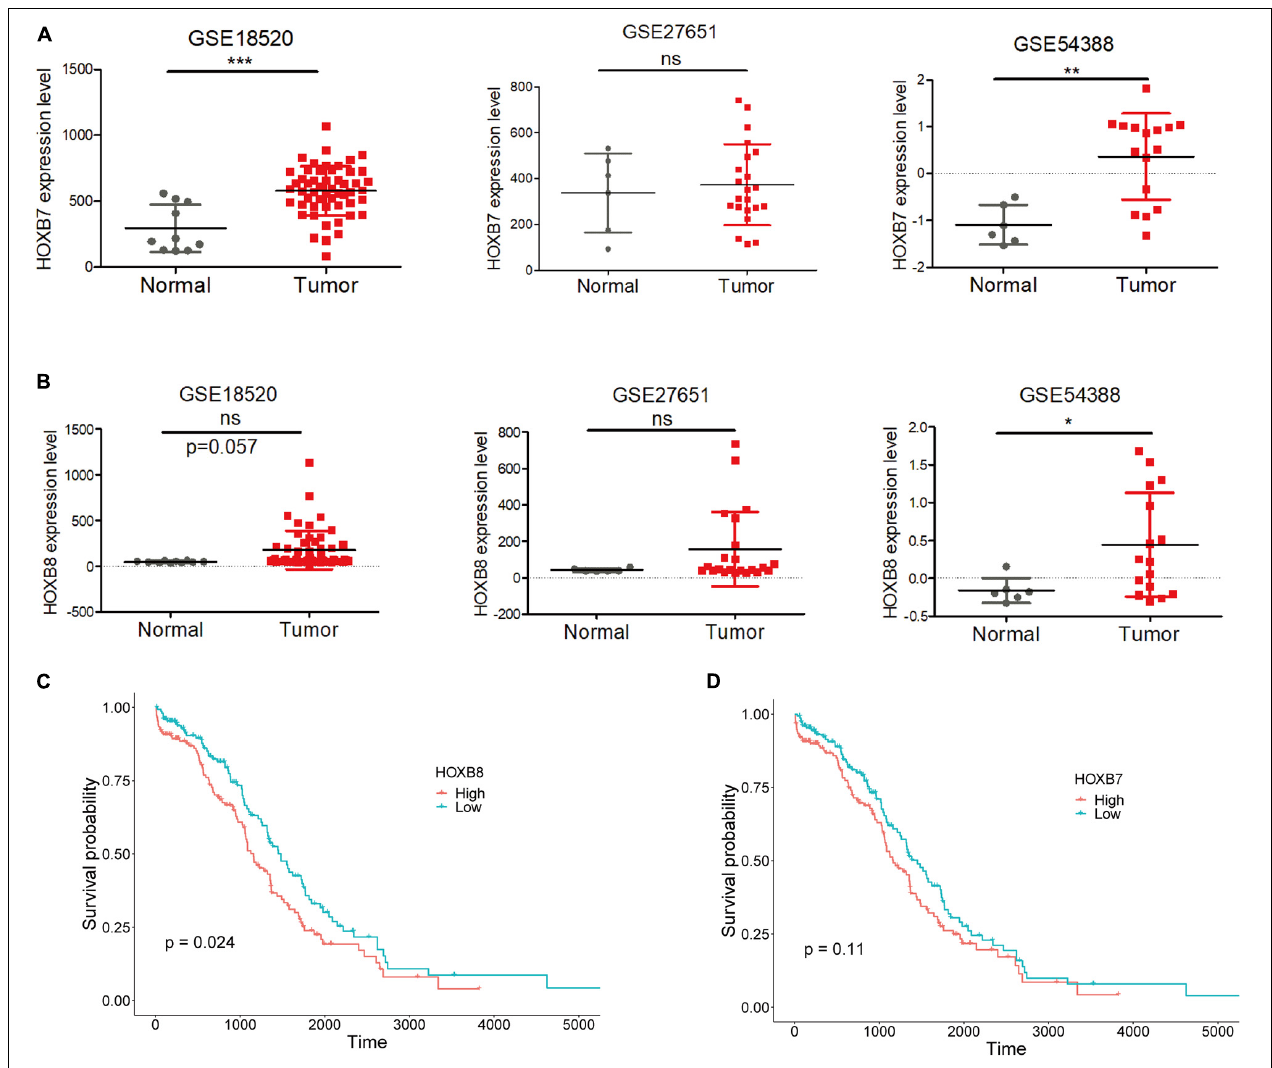
FIGURE 3 | Expression and survival analysis for HOXB7 and HOXB8. (A,B) Expression levels of HOXB7 (A) and HOXB8 (B) in three GEO datasets. (C,D) Overall survival analysis for EOC patients in the TCGA database was based on the expression of HOXB8 (C) and HOXB7 (D) expression from TCGA data. Median expression was used to stratify the high and low expression groups. ns: not significant, * p < 0.05, ** p < 0.01, *** p < 0.001 as determined by an unpaired, two-tailed Student’s t